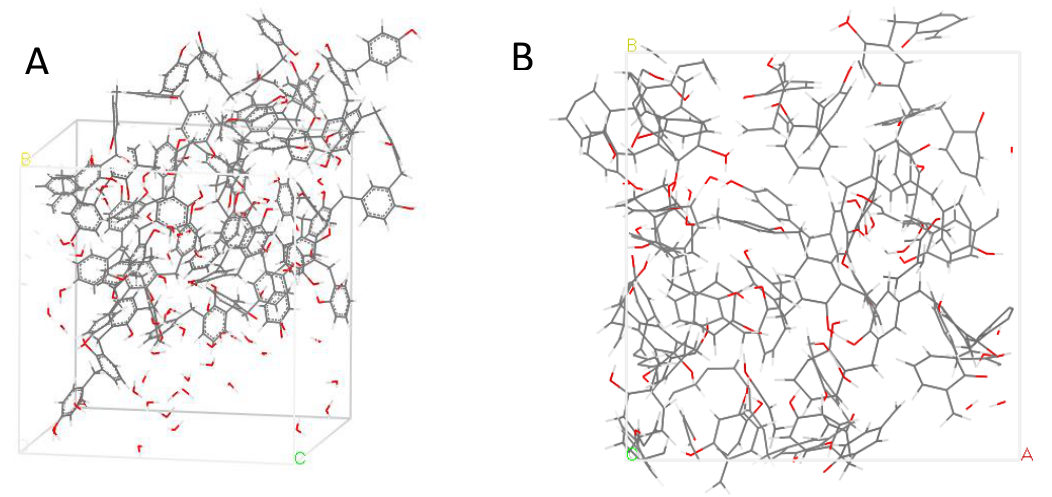
Figure 5. (A ) Model of 1000 atoms, 100% cured (wet). ( B ) Model of 1000 atoms, 100% cured after 5 ps RMD simulation at 1250 K.